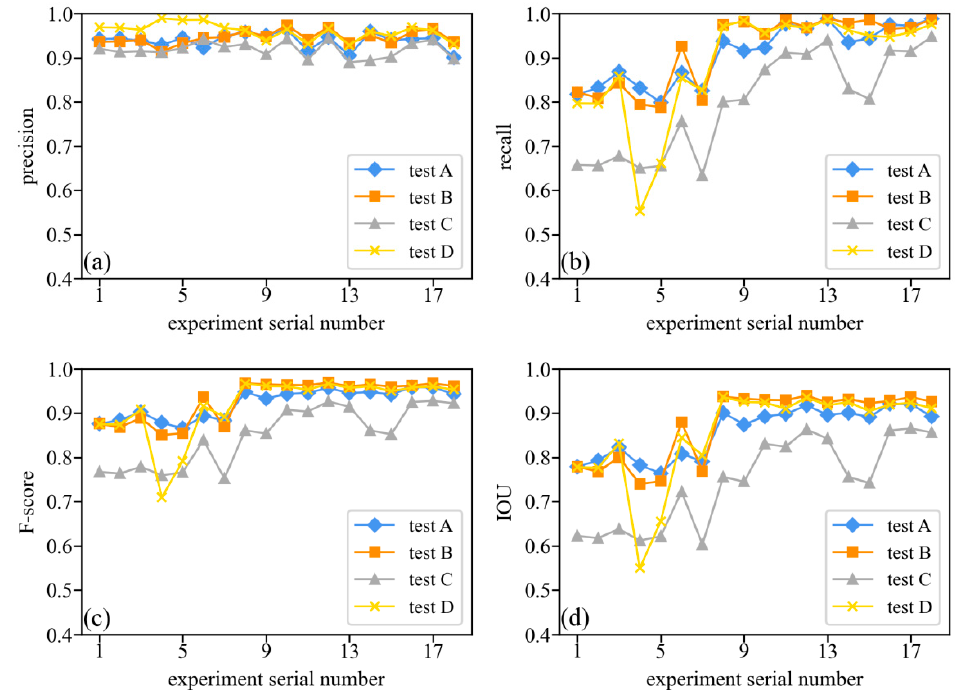
Figure 15. Evaluation index value of cage aquaculture of four test images. ( a ) Precision. ( b ) Recall. ( c ) F-score. ( d ) IOU.